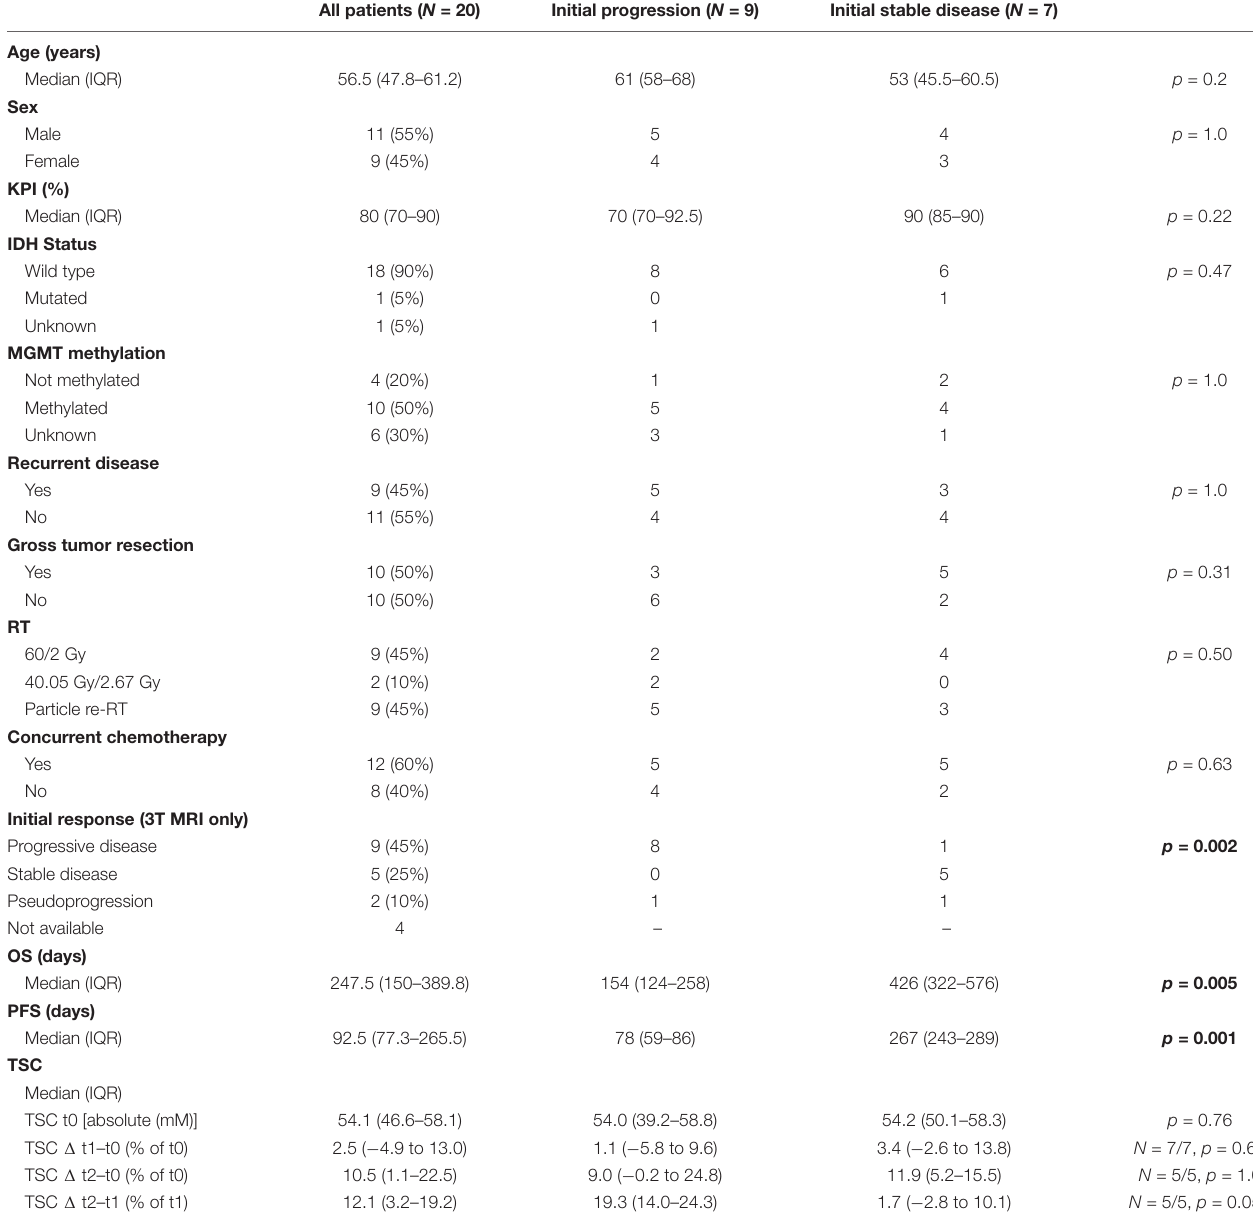
TABLE 1 | Patient characteristics ( N =